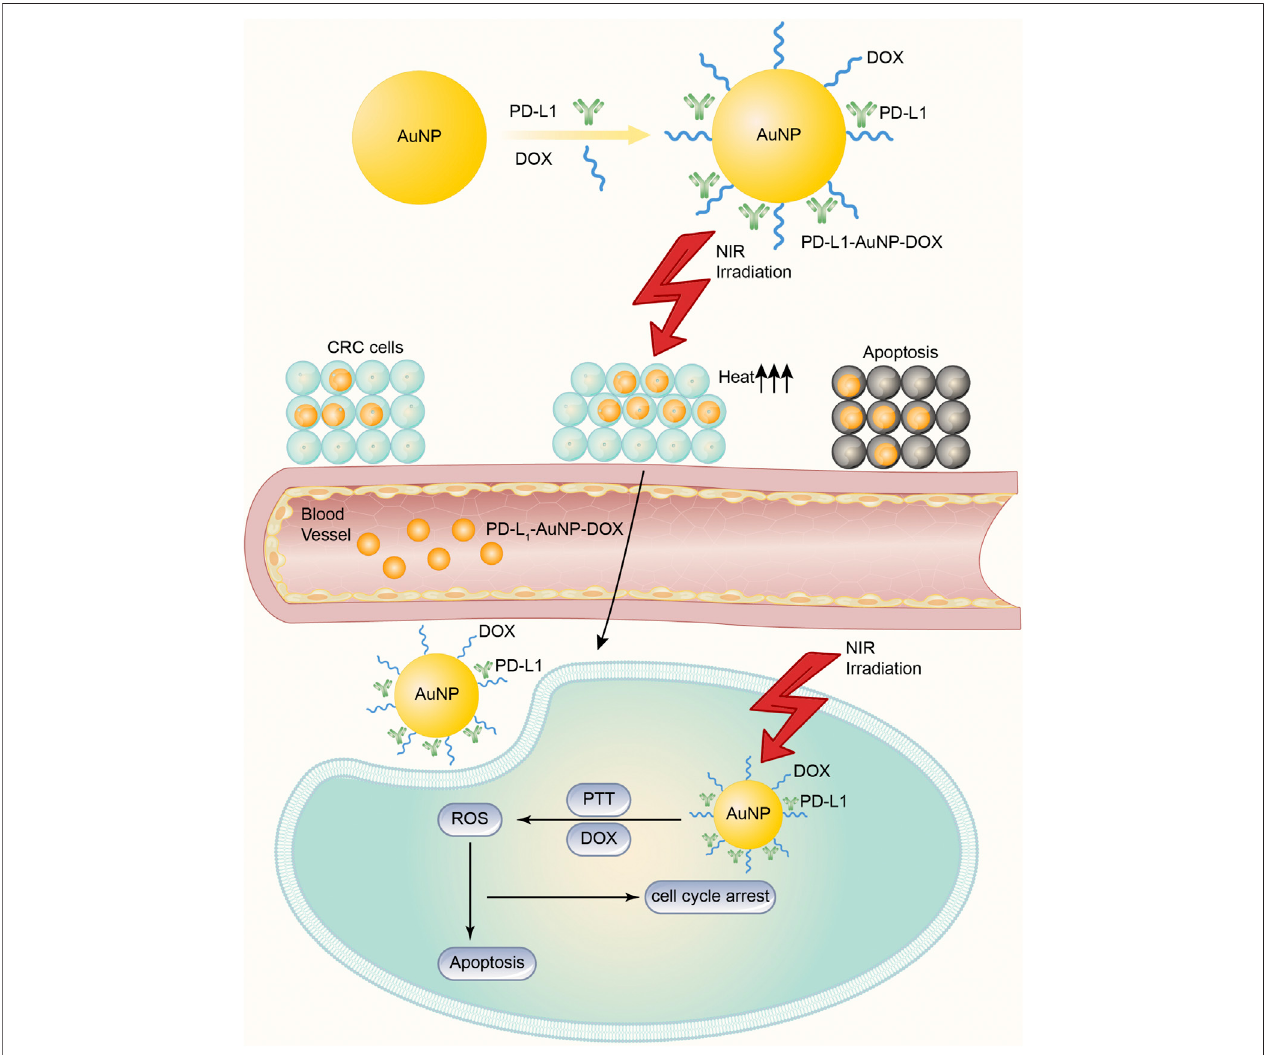
FIGURE 2 | DOX-conjugated and anti-PD-L1 targeting gold nanoparticles (PD-L1-AuNPs-DOX) model for CRC. The PD-L1-AuNPs-DOX model, under the NIR irradiation, may improve the ability of targeted delivery, and gather PD-L1 and DOX together in cancer cells more easily. Then the model effectively generates ROS to increase apoptosis and cell cycle arrest to suppress the in vitro proliferation of CRC